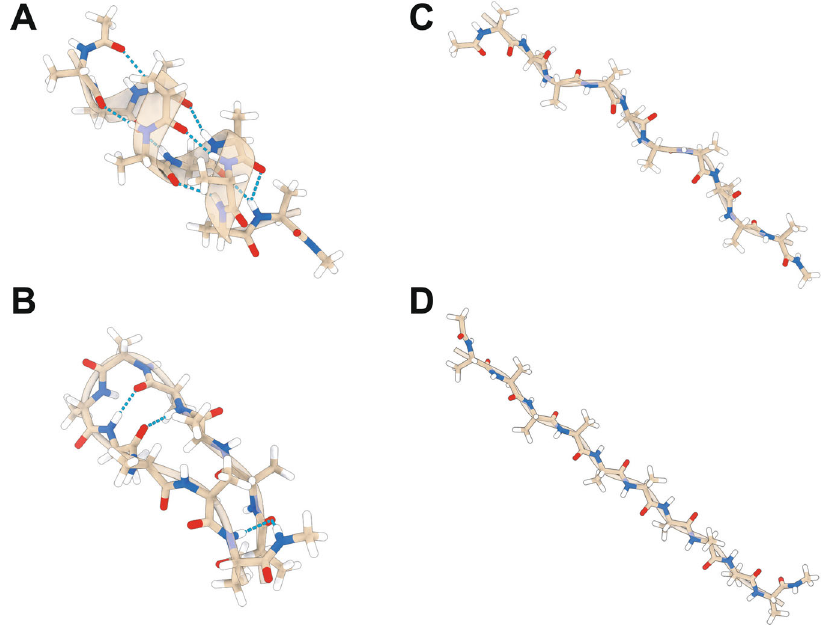
Fig. 4 Various conformations of deca-alanine. Deca-alanine in α -helix ( A ), hairpin ( B ), poly-proline ( C ), and unfolded ( D ) conformation. Atoms are colored by element (i.e., hydrogen in white, carbon in tan, nitrogen in blue, and oxygen in red), the secondary structure is represented by transparent ribbons, and H bonds are shown in cyan, whenever they are